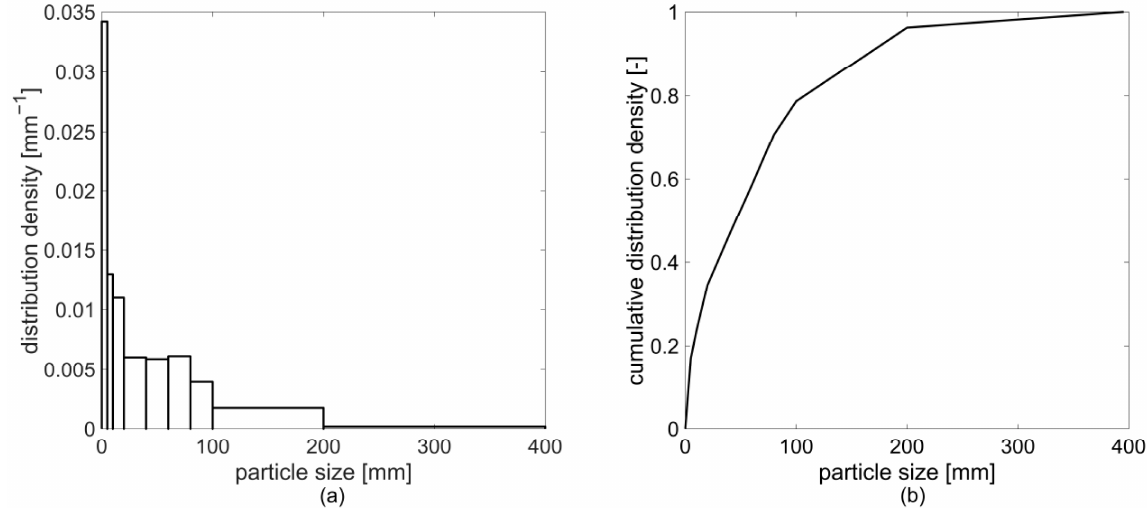
Figure 1. Representation of the overall particle size distribution (PSD) of a mixed commercial waste according to Refer- ence [7]: ( a ) frequency density; ( b ) cumulative frequency